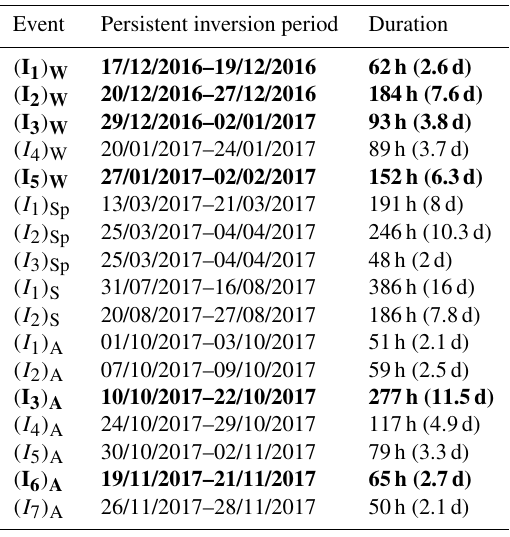
Table 4. Persistent temperature inversion events (I i ) by season (winter, W; spring, Sp; summer, S; autumn, A) detected by pseudo- vertical temperature gradient method (TGM), including time period and